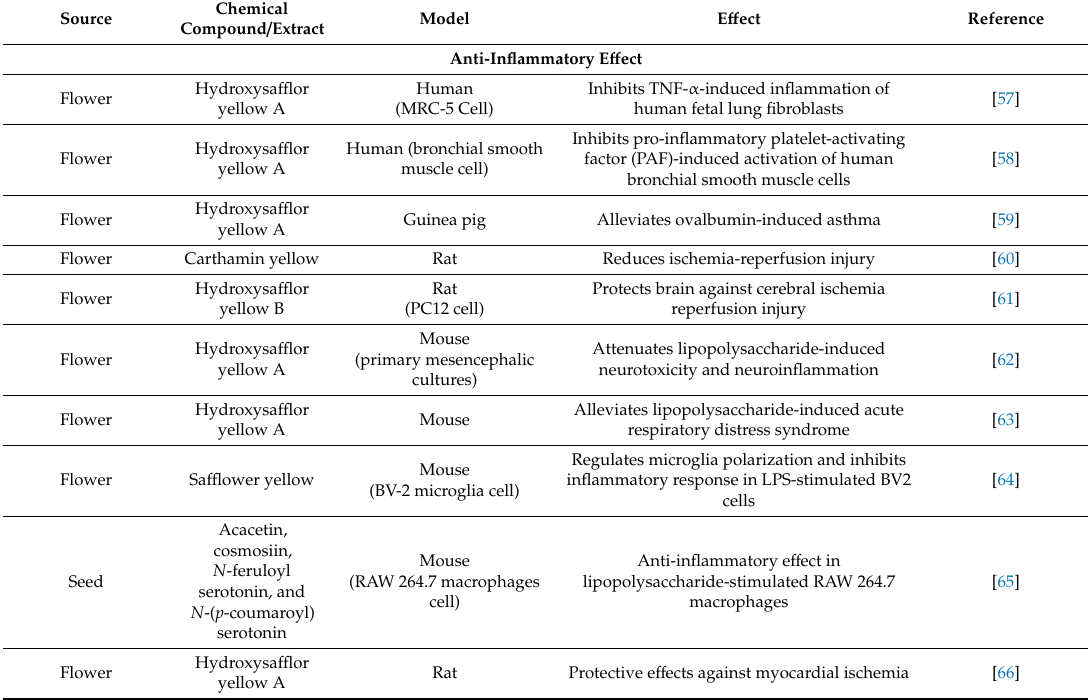
Table 1. List of sa ffl ower metabolites / extracts and their known uses in the